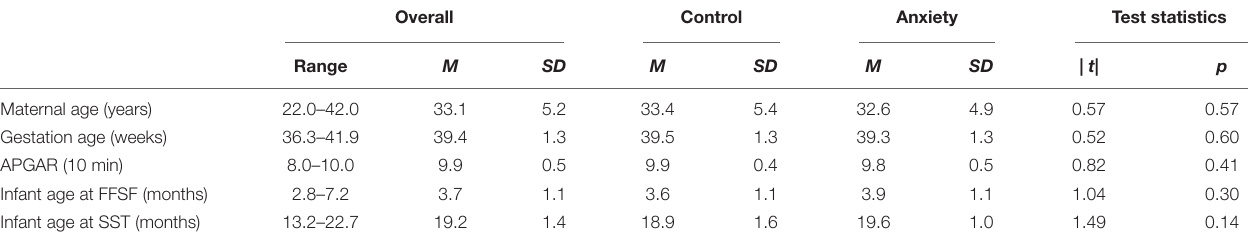
TABLE 1A | Maternal and infant parametric demographics and tests on comparability of subgroups 3–8 months postpartum (Study 1). Overall Control Anxiety Test statistics